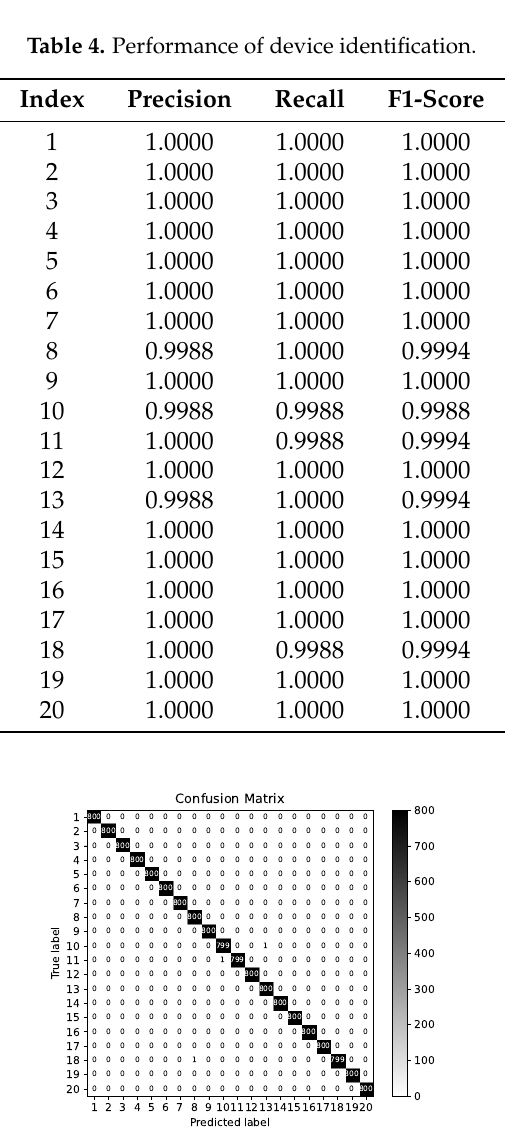
Figure 4. Device identification in matrix